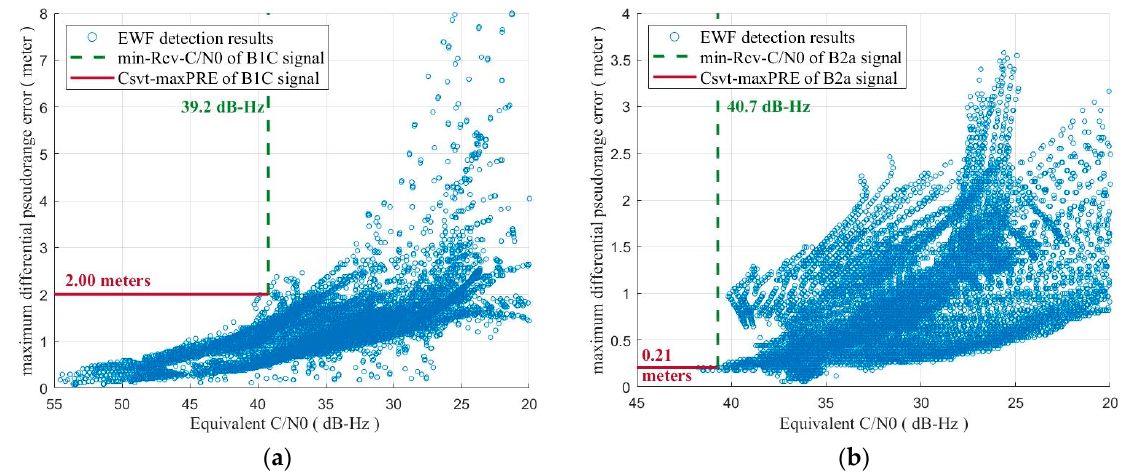
Figure 2. Evaluation results of the MCO-based SQM baseline algorithm. ( a ) B1C signal; ( b ) B2a signal.